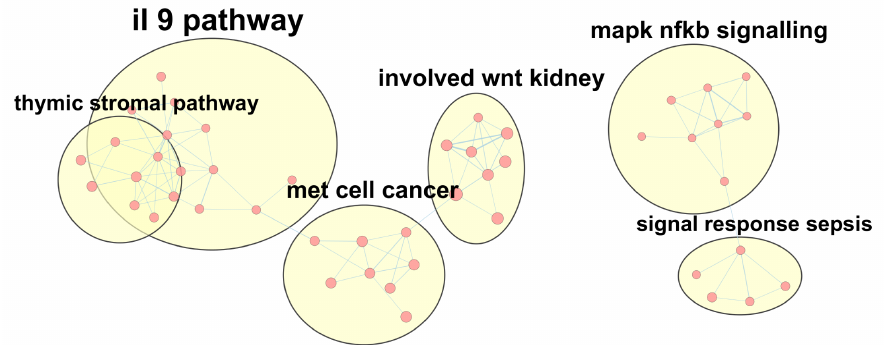
Figure 2. Annotated enrichment map of pathways. A few of the largest clusters of pathways from WikiPathways are displayed as a network with WordCloud-based labels annotating groups (yellow areas). The size of the labels correspond to the size of the